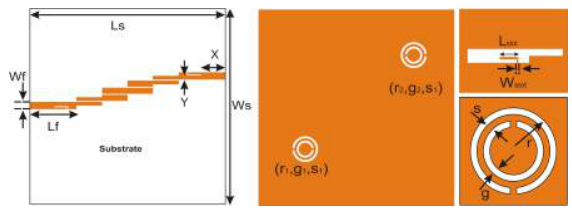
Figure 4: Configration of the filter with stubs and CSRRs ( r 1 = r 2 , g 1 = g 2 , s 1 = s 2 , x = 4 : 2 mm , y = 0 : 3 mm ,